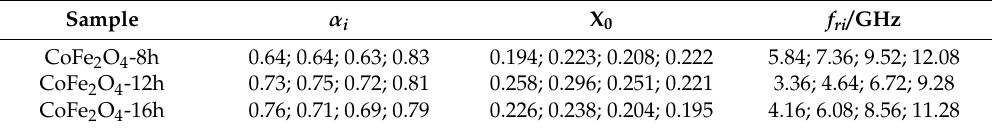
Figure 6. The fitting curve of the imaginary part of effective permeability, ( a ) 8 h; ( b ) 12 h; ( c ) 16 h. Table 2. Fitting parameters for the imaginary part of the effective permeability spectrum.